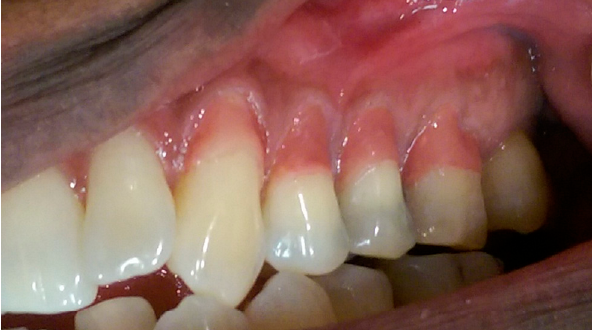
Figure 4. Blending of dark, white and light opaquers. Dent. J. 2017 , 5 , 33